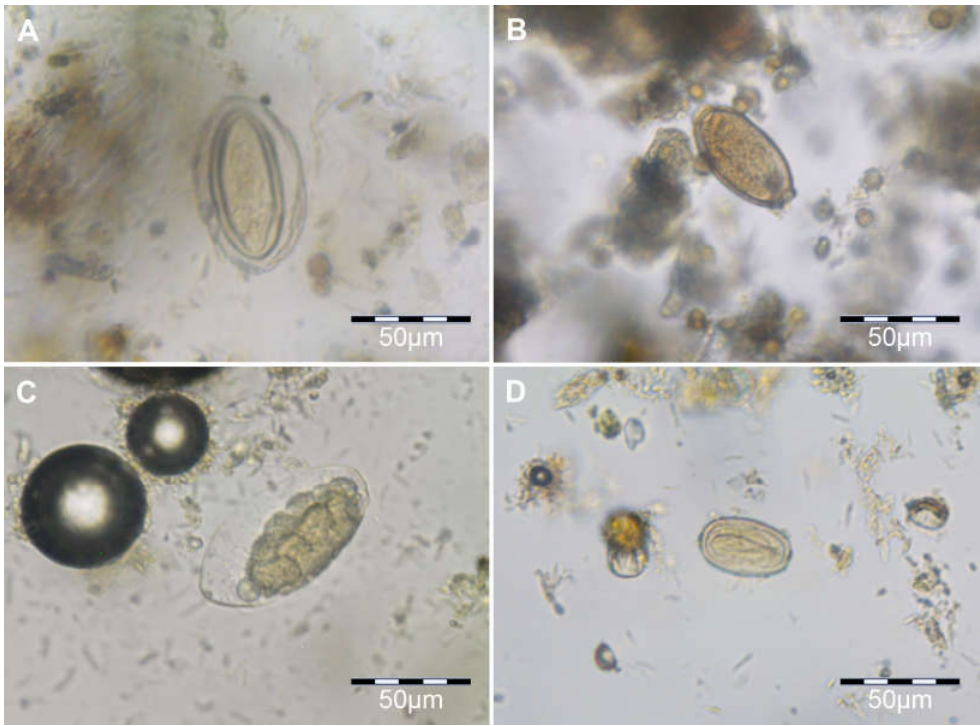
Figure 1. Eggs of helminths found during the coprological study, identified as belonging to Acanthocephala ( A ), Capillariidae ( B ), Trichostrongylidae ( C ), and Spiruroidea ( D ).